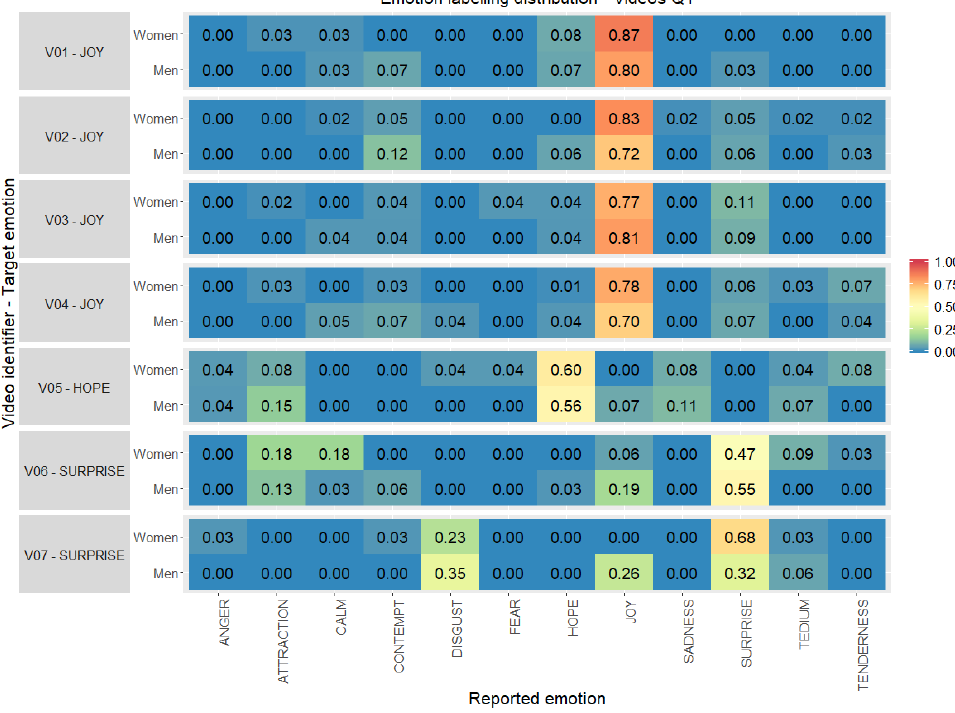
Figure 4. Emotion labelling distribution (0.00–1.00) between the emotions reported by the volunteers with respect to the original target per video clip selected, gender and quadrant 1 (percentage computed considering individually women and men totals per stimuli).